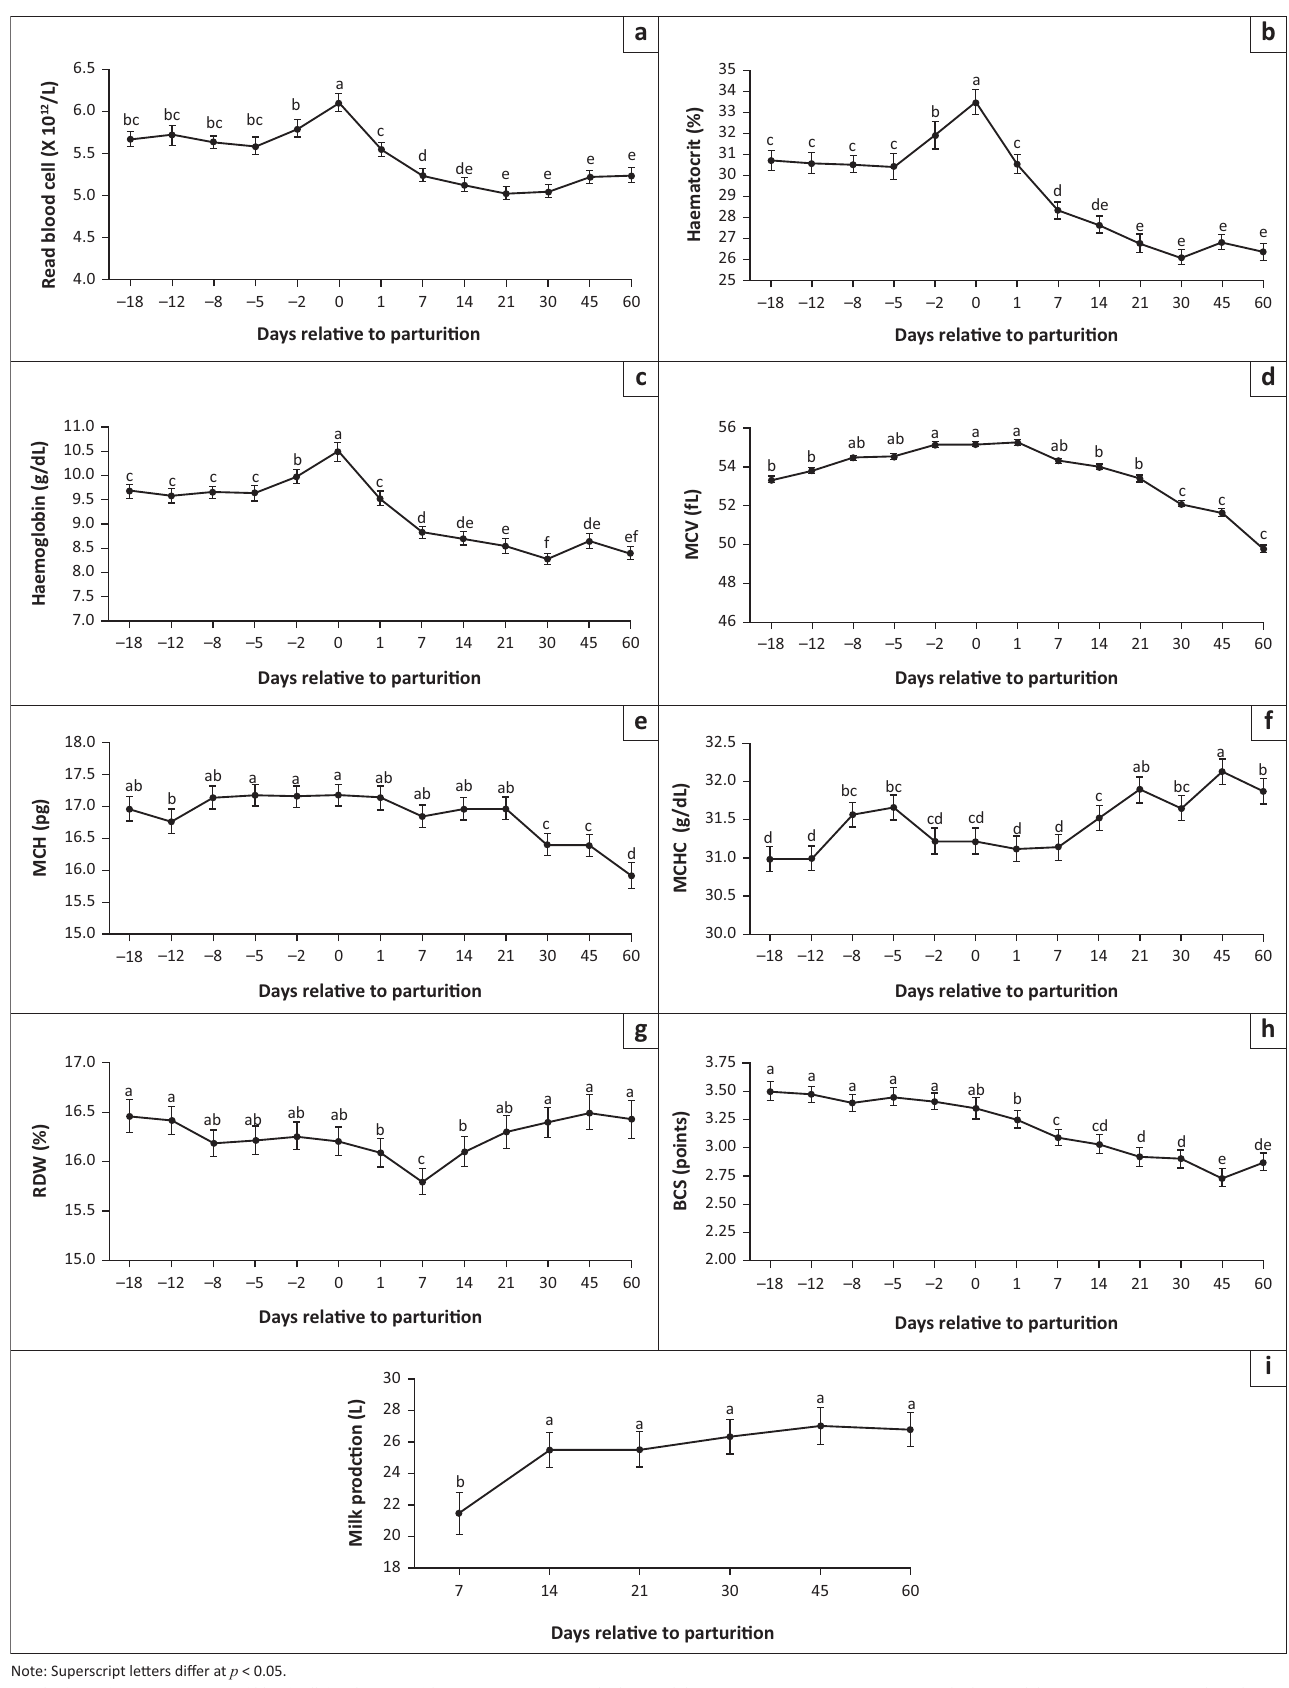
FIGURE 1: Mean (±SE) (a) red blood cell (×10 12 /L), (b) haematocrit ( % ), (c) haemoglobin (g/dL), (d) mean corpuscular volume (fL), (e) mean corpuscular haemoglobin (pg), (f) mean corpuscular haemoglobin concentration (g/dL), (g) red blood cell distribution width ( % ), (h) body condition score (points) and (i) milk production (L) of Holstein dairy cows during peripartum. Superscript letters differ at p <